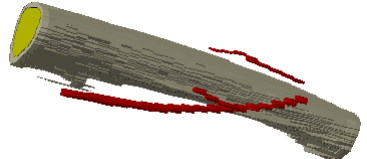
Fig. 14: 3D-view of bone, bone marrow, and